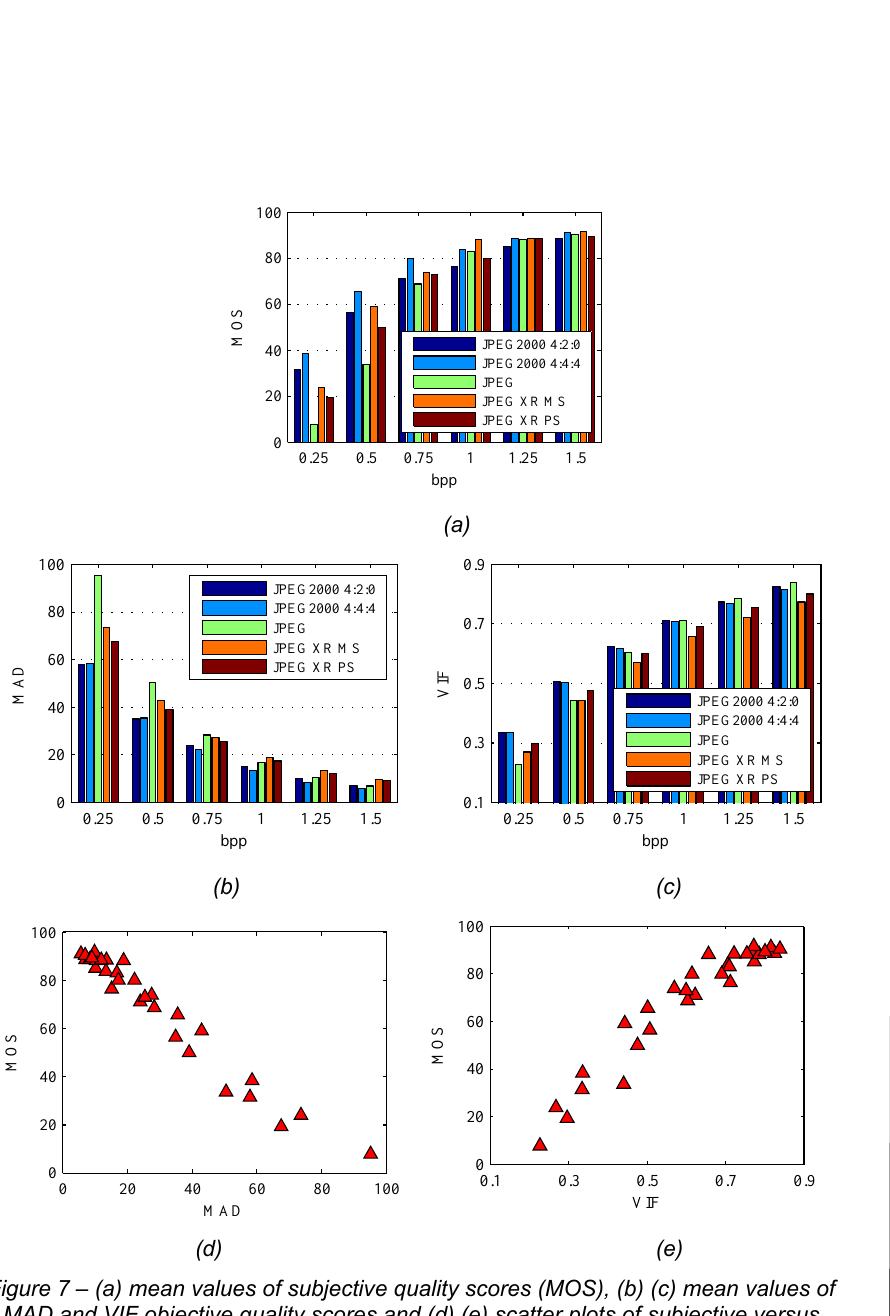
Figure 7 – (a) mean values of subjective quality scores (MOS), (b) (c) mean values of MAD and VIF objective quality scores and (d) (e) scatter plots of subjective versus objective quality predictions after